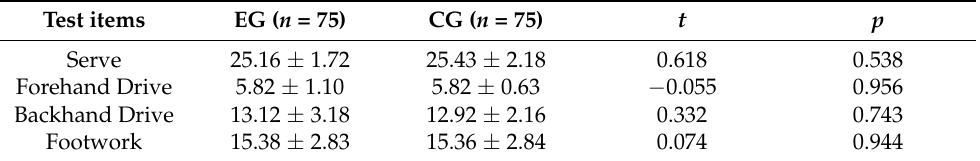
Table 9. Comparison of Tennis Learning Performance between EG and CG before Experimen- tal Teaching.